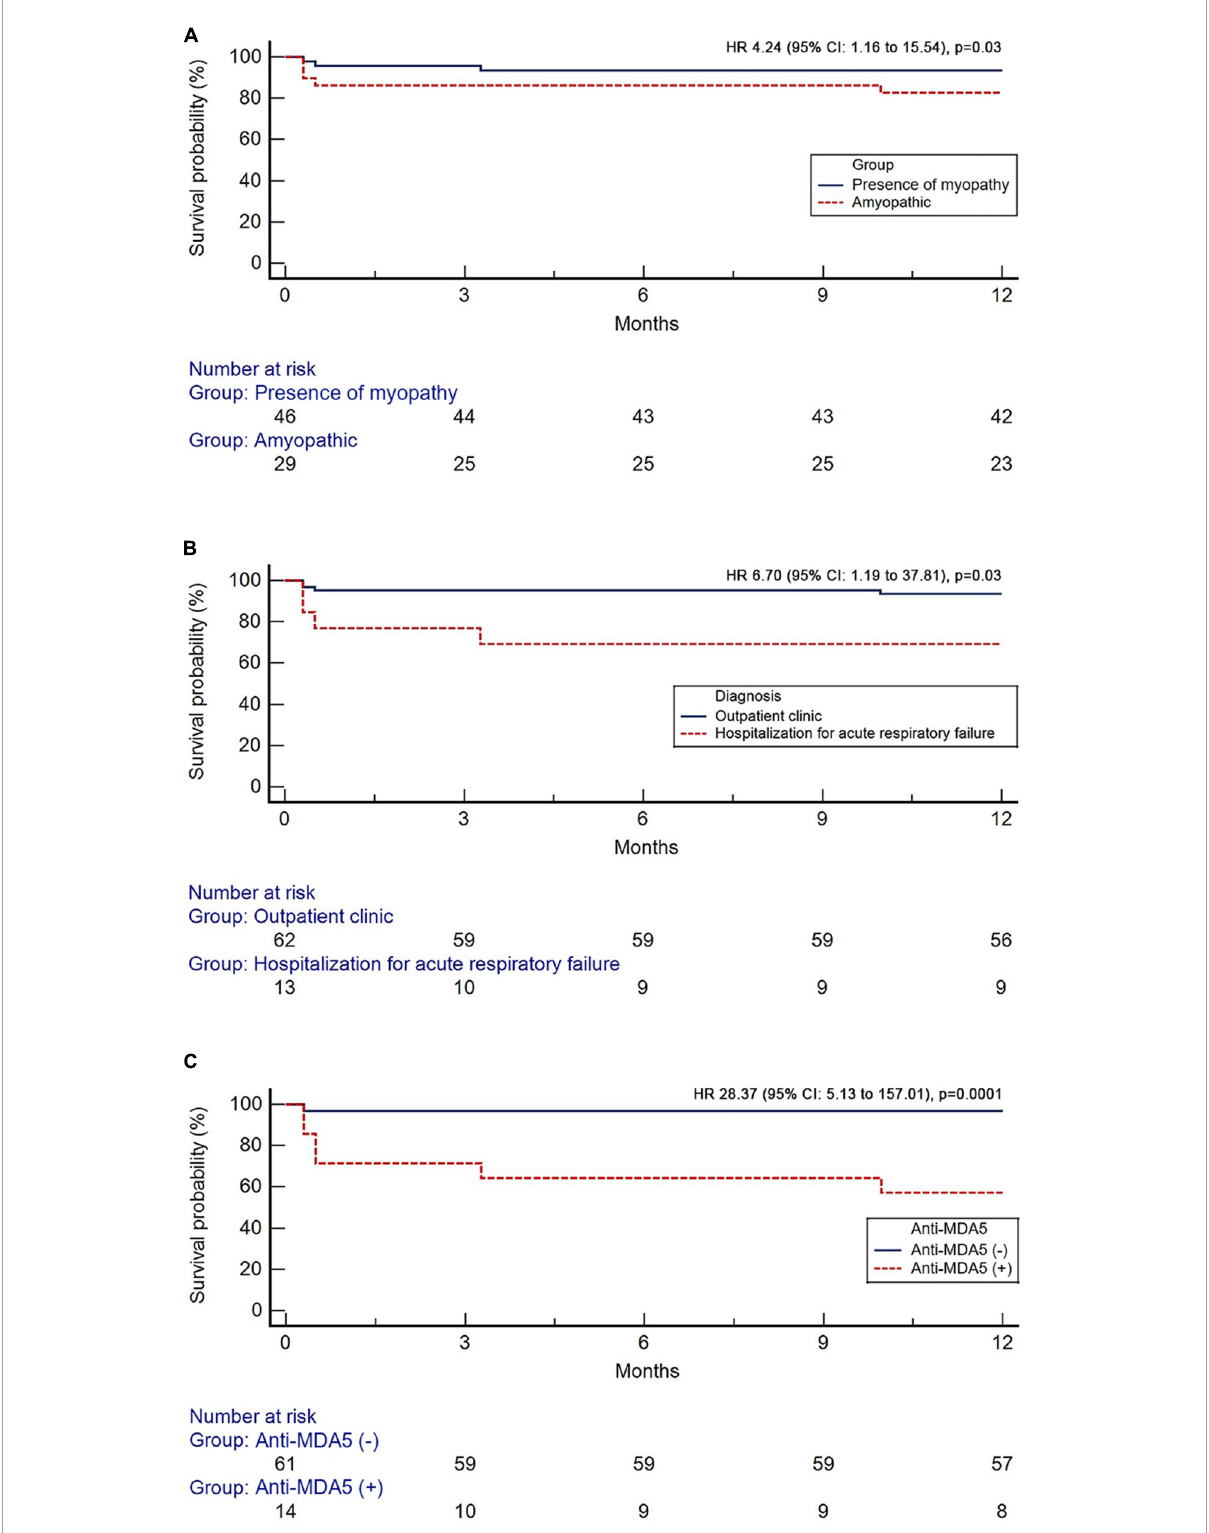
FIGURE2 Kaplan–Meier curves showing the prognostic impact of the absence of myopathy (A) , diagnosis during hospitalization for acute respiratory failure (B) , and anti-MDA5 positivity (C)